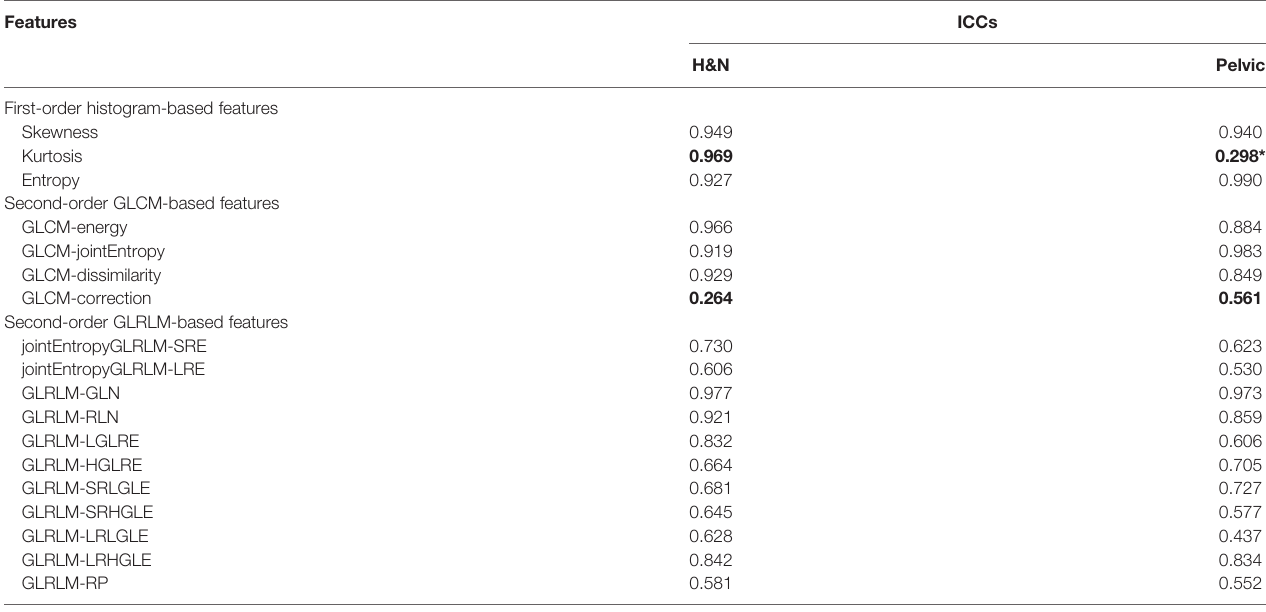
TABLE 2 | The site-speci fi c ICC values of all features analyzed by the two software packages.